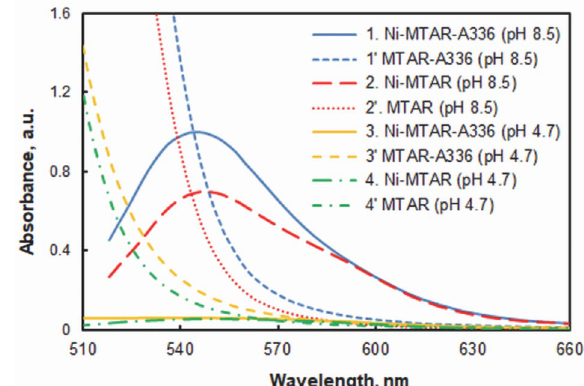
Figure 1. Absorption spectra in isobutanol of complexes against blanks (1 – 4; c Ni = 2 × 10 −5 mol dm −3 , c MTAR = 2.7 × 10 −4 mol dm −3 , c A366 = 5.6 × 10 −3 mol dm −3 , V aq. phase = 10 cm 3 , extraction time t = 60 sec) and corresponding blanks against isobutanol (1’ – 4’). Sam- ples 2, 2’, 4 and 4’ do not contain A336; pH is given in the legend.